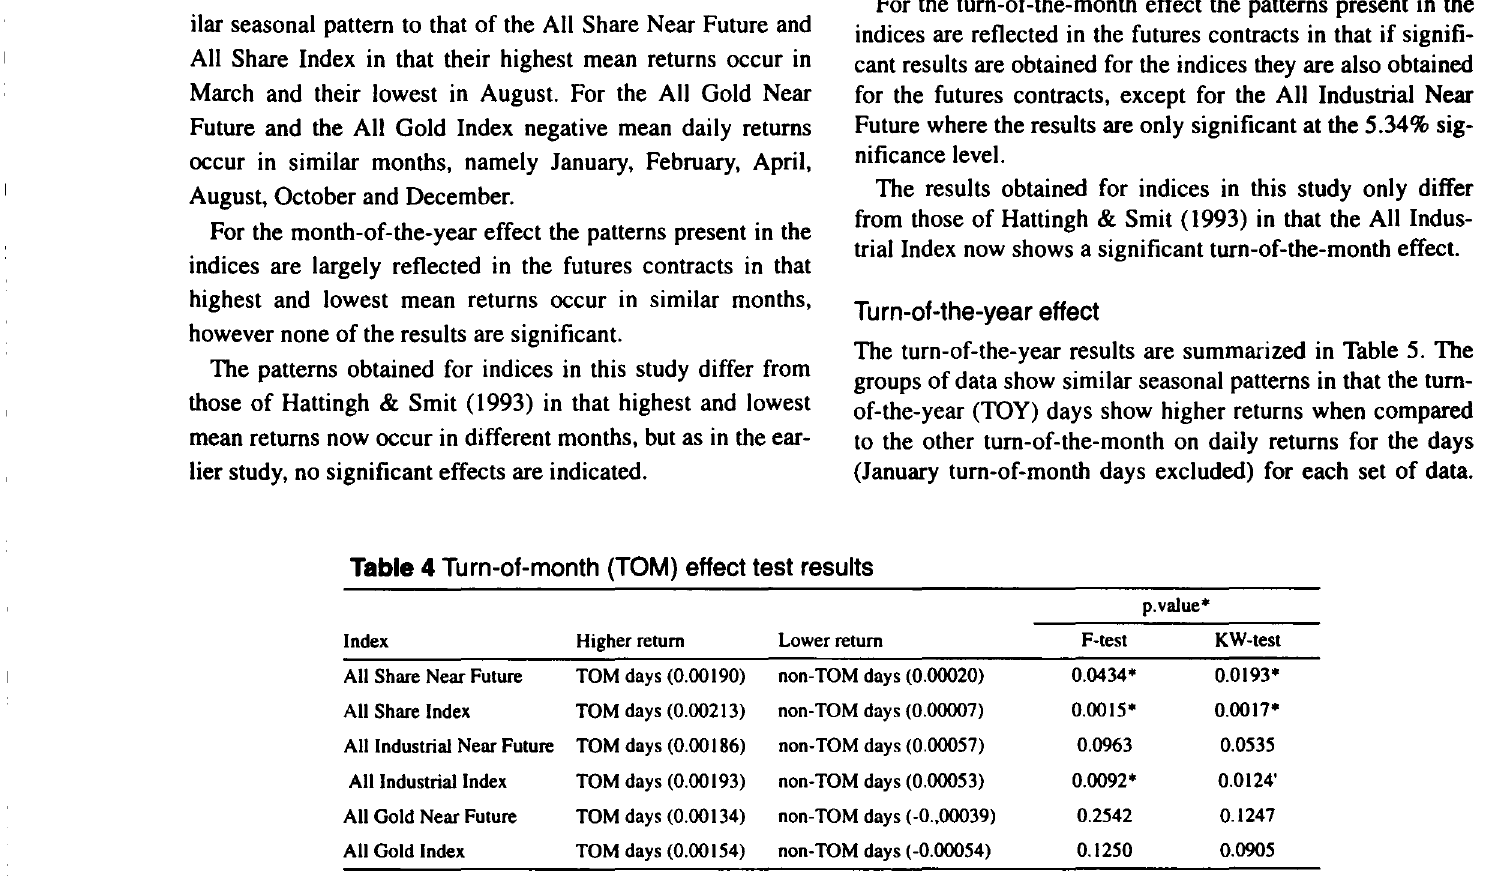
Table 4 Turn-of-month (TOM) effect test